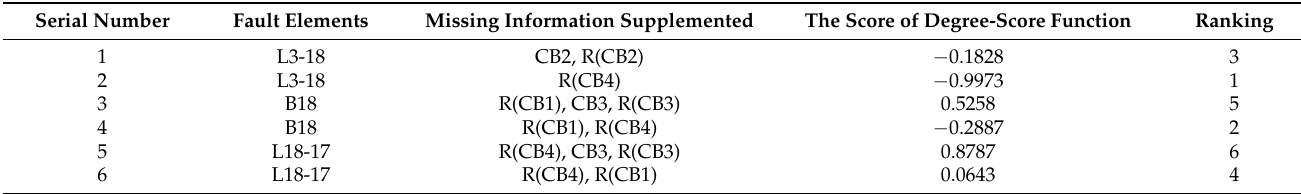
Table 6. Results sorted with DFTS.